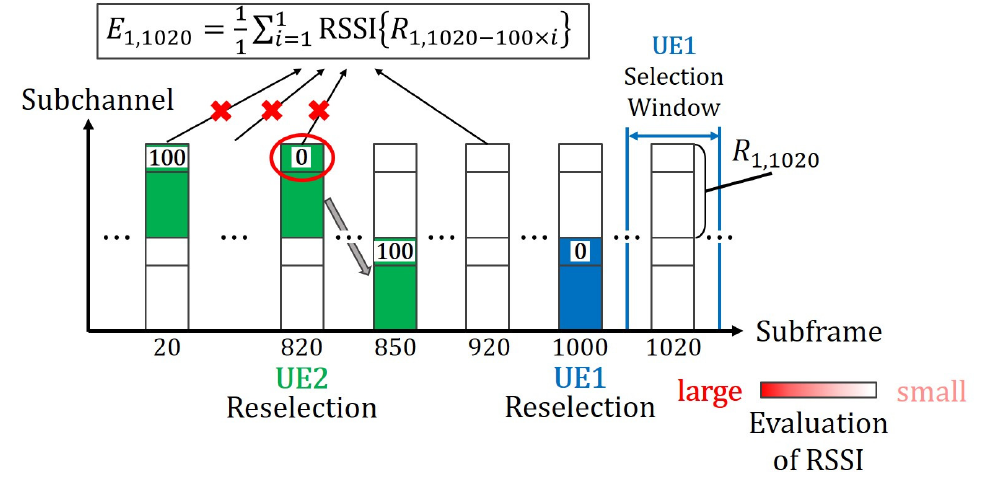
Figure 8. An example of the PA